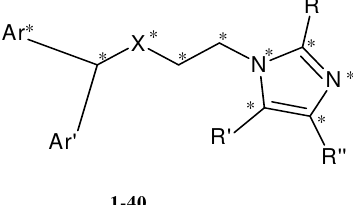
Figure1. Novel DAMNI analogs used for 3D QSAR studies. Common substructure is labeled